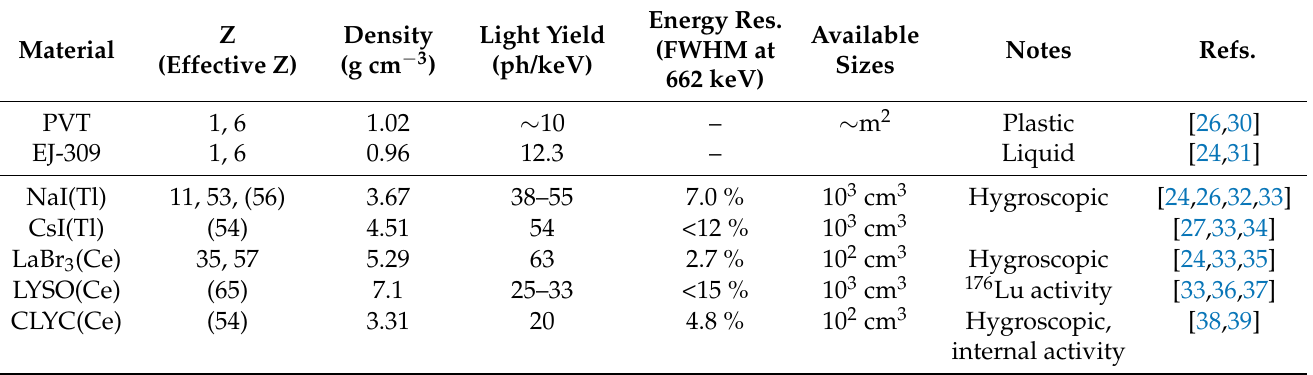
Table 1. Properties of different organic (top) and inorganic (bottom) radiation detection materials used in scintillator detectors. Available sizes are based on typical commercial